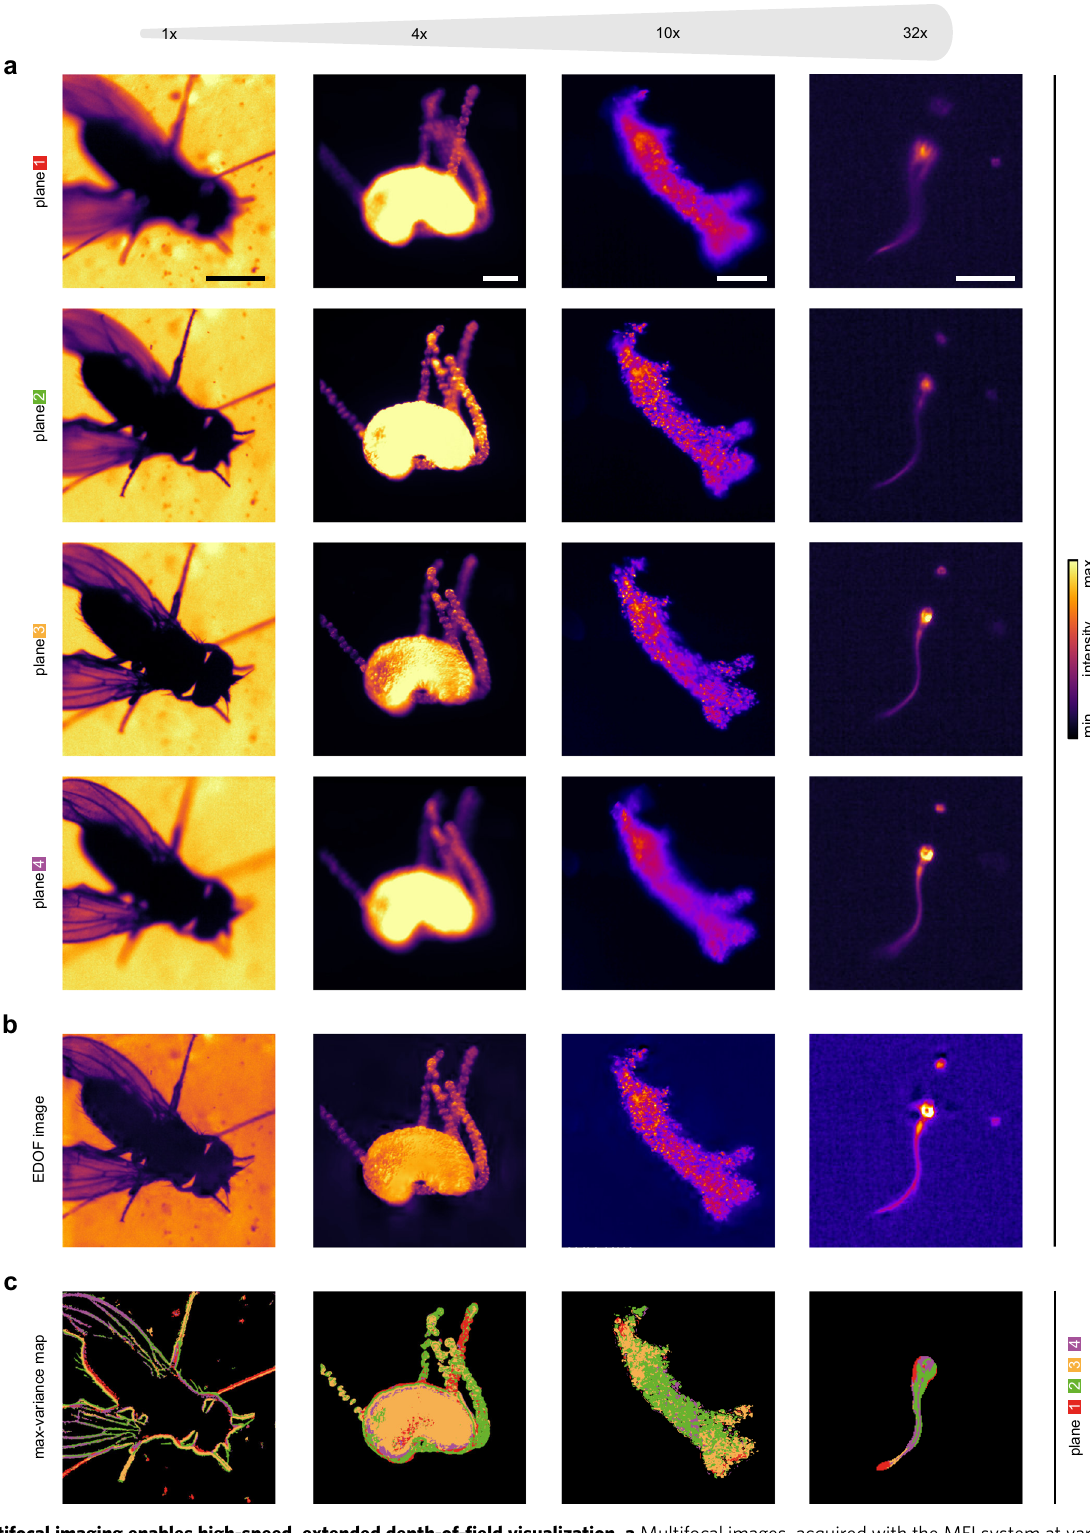
Fig. 1 Multifocal imaging enables high-speed, extended depth-of- fi eld visualization. a Multifocal images, acquired with the MFI system at various scales, demonstrate that MFI can be used to simultaneously image fast-moving objects at different depths. Left to right: grooming Drosophila melanogaster (1×; scale bar 1 mm, bright- fi eld microscopy), foraging Hydra vulgaris (4×; scale bar 200 µ m, dark- fi eld microscopy), crawling Amoeba proteus (10×; scale bar 100 µ m, dark- fi eld microscopy), and swimming human sperm cell (32×; scale bar 20 µ m, dark- fi eld microscopy). b Extended depth-of- fi eld (EDOF) images produced from multifocal images shown in a . c Max-variance maps showing for speci fi c pixel positions the planes (color-coded) wherein the specimen appeared most sharp (sharpness determined as pixel variance), revealing a coarse feature localization of the object in z . Experiments replicated three times with similar